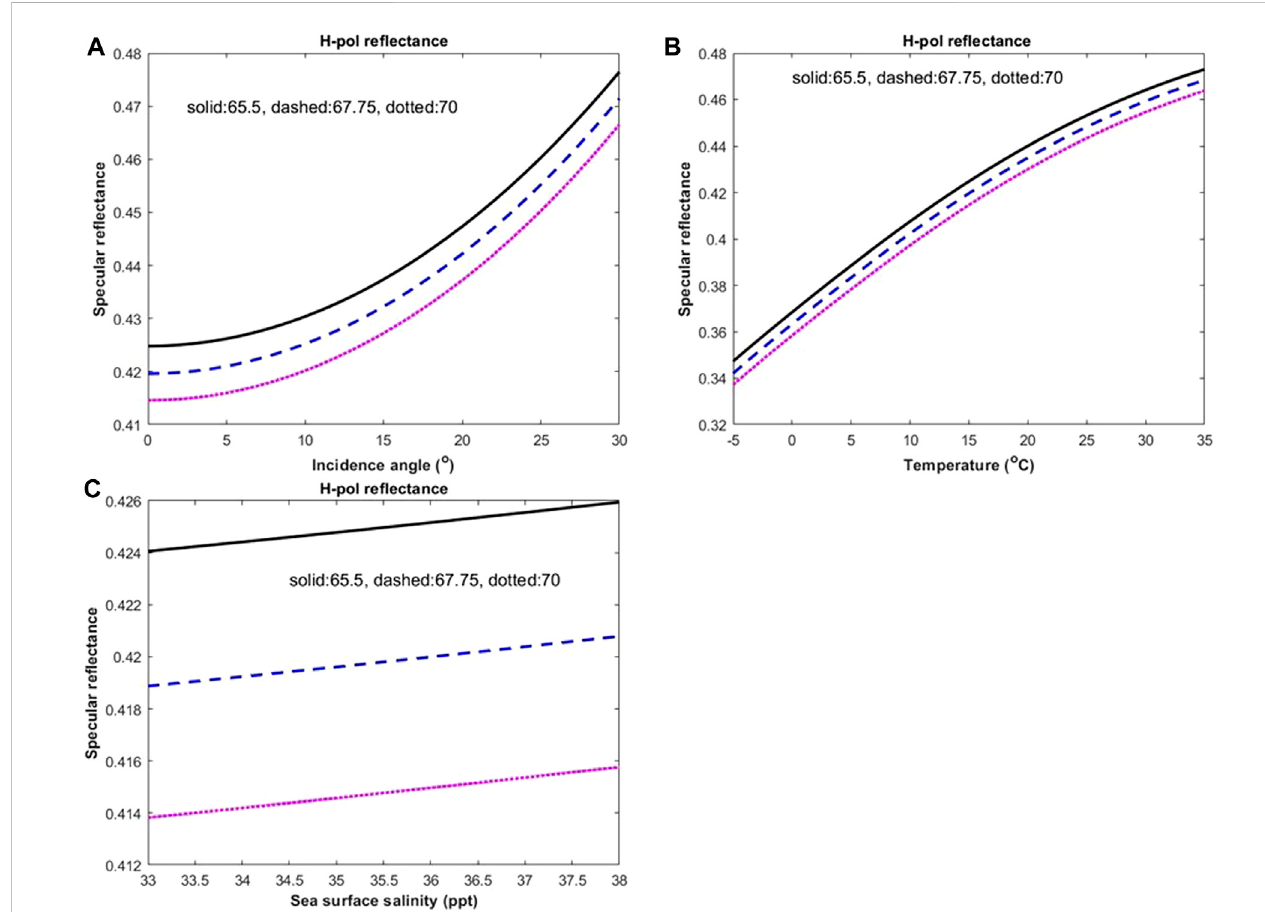
FIGURE 1 Variations of simulated horizontally polarized (H-pol) specular re fl ectance values of seawater at 65.5 (black solid curve), 67.75 (blue dashed curve), and 70.0 GHz (magenta dotted curve) V-band frequencies with (A) incidence angle, θ , (B) sea surface temperature, SST, and (C) sea surface salinity, SSS. If not mentioned, the basic environmental condition of 0 ° θ , 15 ° C SST and 35 ppt SSS is assumed as discussed in the